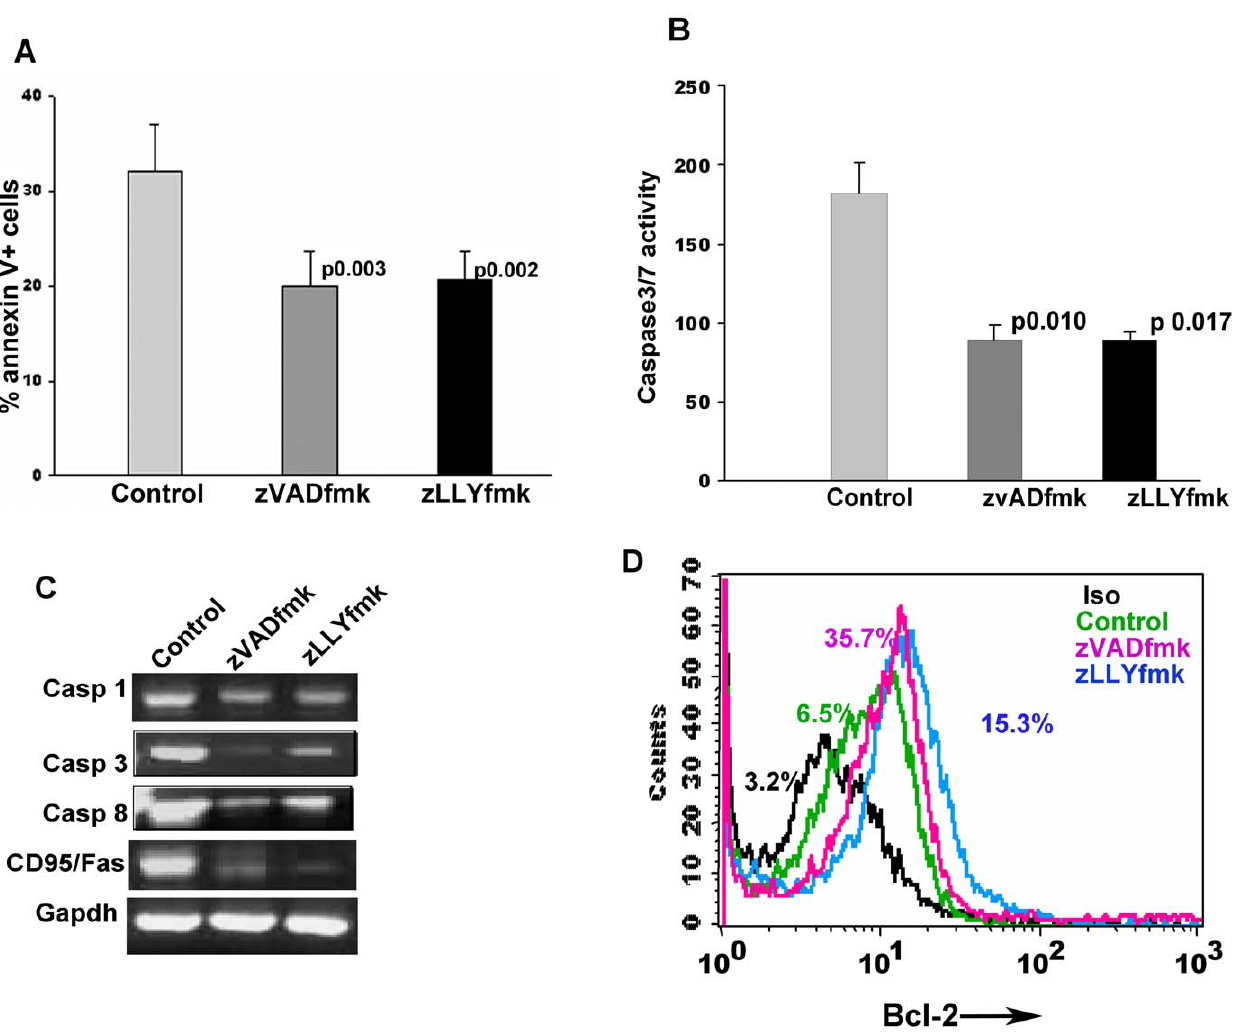
Figure 1. zVADfmk and zLLYfmk reduced the level of apoptosis during ex vivo expansion. (A) The expanded control and zVADfmk/ zLLYfmk cells were assessed for the expression of pro and anti apoptotic molecules. Annexin V staining was carried out to detect the apoptotic population. The percent annexinV + population decreased significantly when the CD34 + cells were cultured in the presence of either of the protease inhibitors showing a reduced level of apoptosis in the culture. Data represented as mean positive population 6 standard deviation from five independent experiments n=5 (B) The presence of active caspases (Casp3/7) in the culture was assessed using a cell free cytosolic enzymatic assay and the zVADfmk/zLLYfmk sets showed a significant reduction in the activity of these caspases as assessed from four different CB units. Data is represented as mean 6 standard deviation. (n=4). (C) The transcript analysis of various pro apoptotic genes like caspase 1, caspase 3, caspase 8 and CD95/Fas, revealed a reduction in their expression upon protease inhibition compared to the control. (D) The analysis for the presence of anti apoptotic bcl-2 showed a significant increase in the cells expanded with zVADfmk/zLLYfmk. Representative flowcytometry profile is shown. (Black line– Isotype, green line – control, pink line – zVADfmk and blue line- zLLYfmk respectively